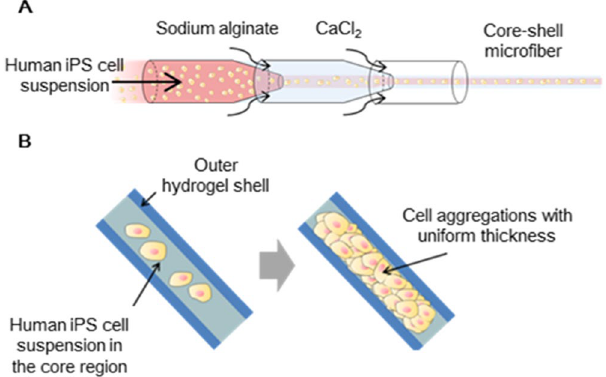
Figure 1. Schematic illustration of the core-shell microfiber culture system for human induced pluripotent stem (iPS) cells. ( A ) An illustration of the double co-axial laminar flow microfluidic device used for the formation of the human iPS cell-laden core-shell hydrogel microfiber. ( B ) The cells encapsulated within the core-shell microfibers proliferate and form cell aggregations with uniform thickness by expanding along the